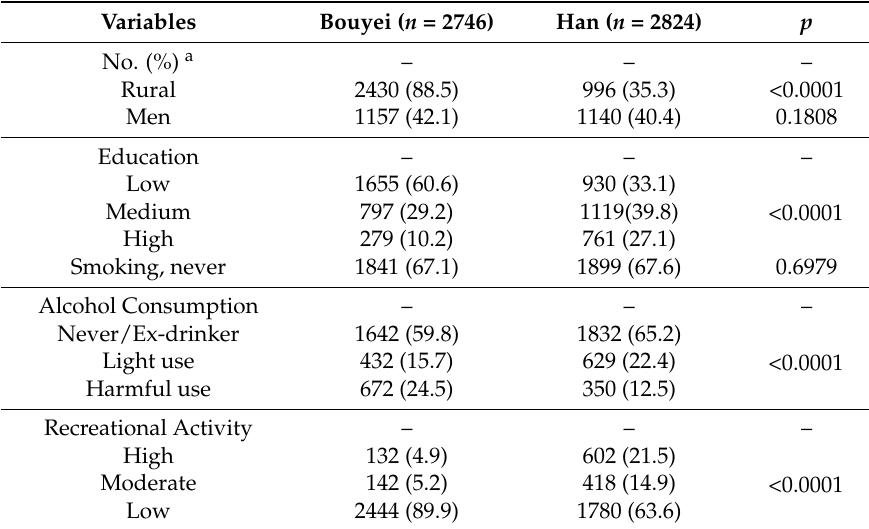
Table 1. Demographic and Health Characteristics of Bouyei and